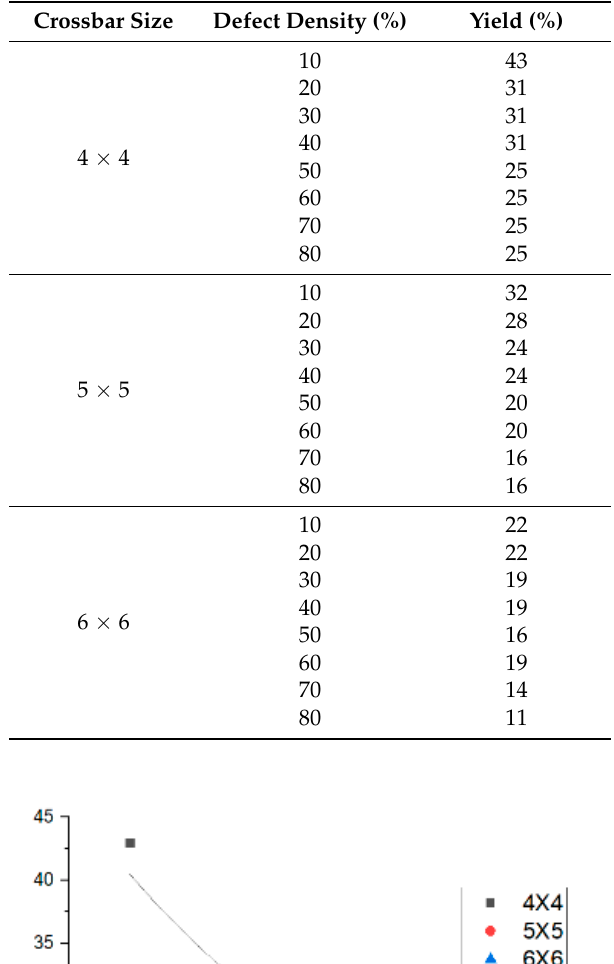
Table 1. Percentage yield analysis for three different sized crossbars with different densities. Crossbar Size